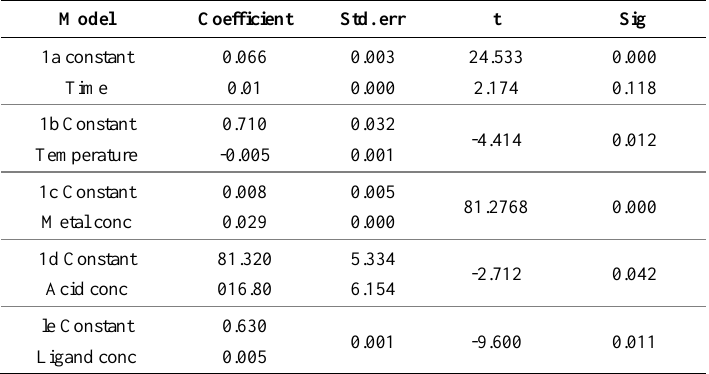
Table 3. Result of Regression analysis for the preparation and extraction of Mn(II) H2 S AL